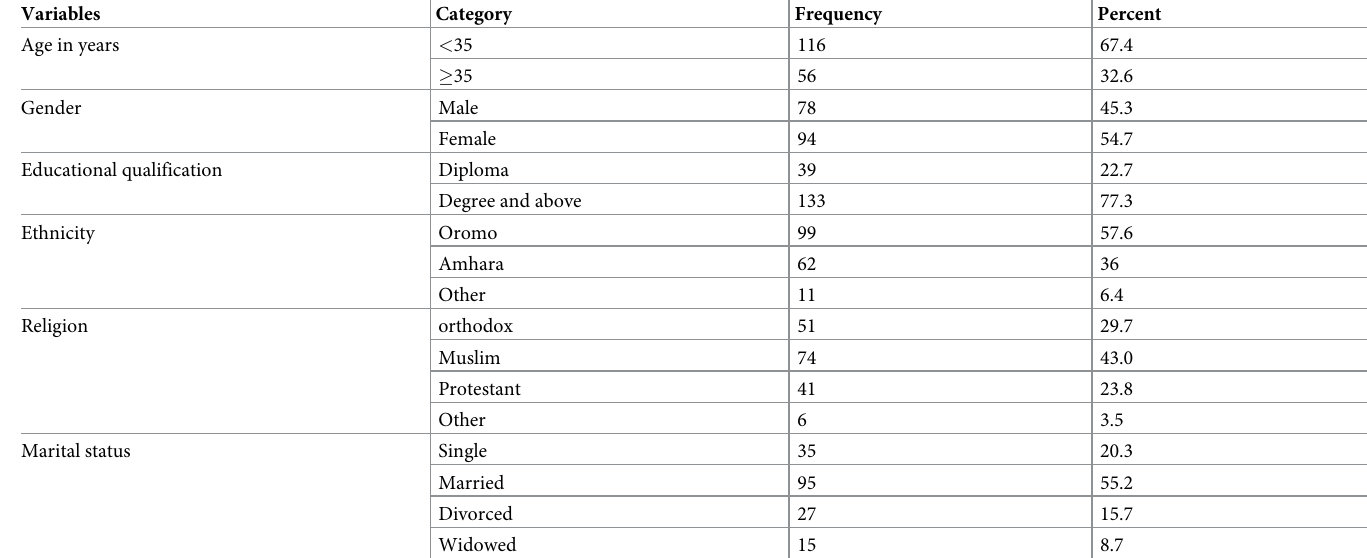
Table 1. Sociodemographic characteristics of nurses’ working at Asella Referral and Teaching Hospital, Asella, Ethiopia, 2021, [n = 172]. Variables